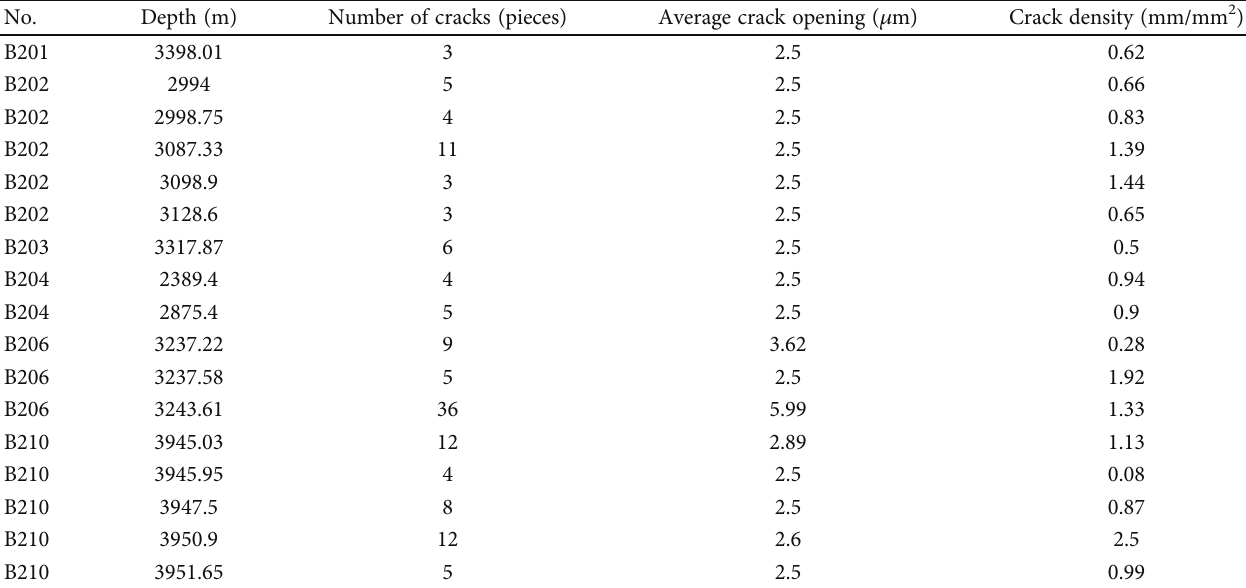
Figure 5: (a) Grained fractures, well B206, 3243.61m (-). (b) Enveloping fractures, B210 wells, 3945.08m (-). (c) Structural fractures, B208 wells, 3261.45m (-). (d) Grained fracture dissolution, well B210, 4127.2m (-). (e) Fracture is fi lled with organic matter, well B203, 3607.8 m (-). Table 1: Statistical table of microcrack image analysis